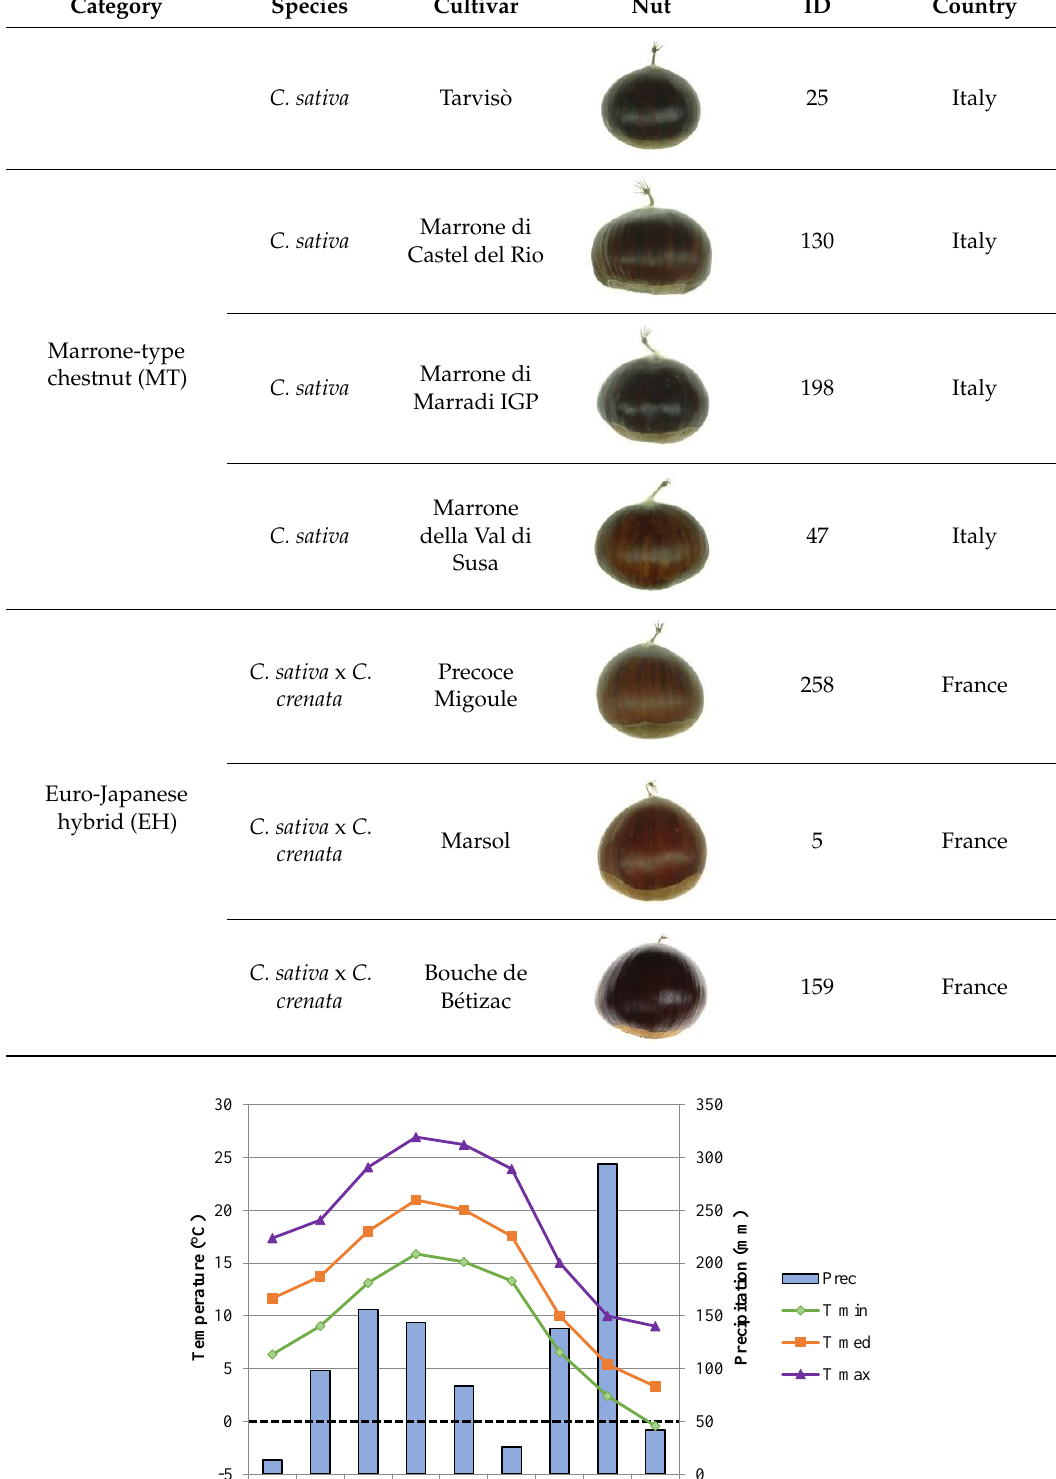
Figure 1. Monthly (maximum, mean, and minimum) temperature and rainfall values available from April to December 2018. 2.2. Sample Preparation